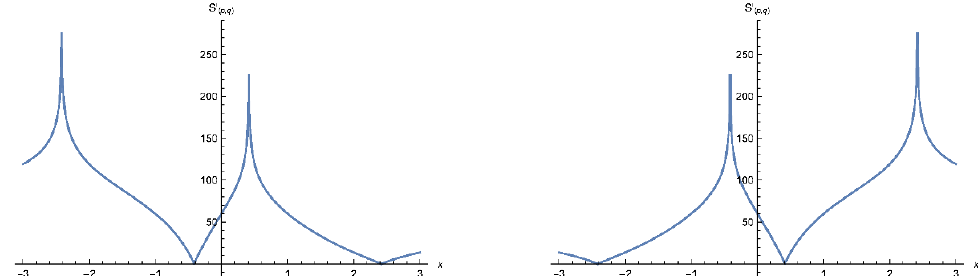
Figure 9 . The energy pro(cid:12)le of a probe string placed in a background of type (3.10). Recall that p branes of type (cid:6) ( p 1 ; q 1 ) are located at x = 1 (cid:6) 2 and branes of type (cid:6) ( p 2 ; (cid:0) q 2 ) are located at p x = (cid:0) 1 (cid:6) 2. On the left, we have placed a ( (cid:0) q 1 ; p 1 )-string in this background, and we see that its energy is minimized when the string is coincident with the (cid:6) ( p 1 ; q 1 ) branes. On the right, we have placed a ( q 2 ; p 2 )-string in the same background, and we see that its energy is now minimized when the string is coincident with the (cid:6) ( p 2 ; (cid:0) q 2 ) branes. For explicit results, we have